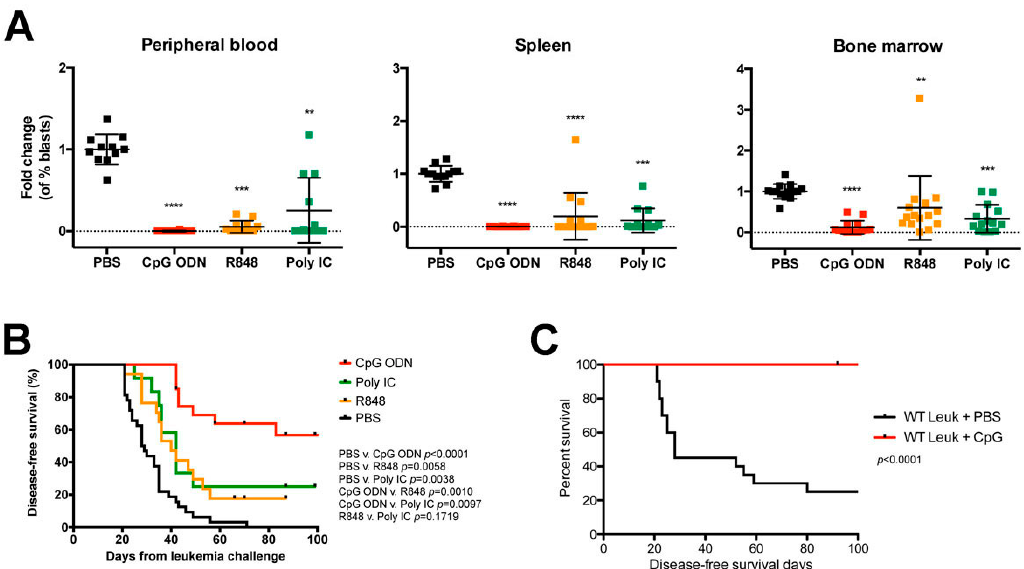
Figure 4. Endosomal TLR-mediated immune stimulation induces protective immune responses in leukemia-bearing mice. BALB/c mice engrafted with syngeneic primary E μ -ret B-ALL cells were treated with indicated TLR agonists and ( A ) evaluated for disease burden in peripheral blood (left), spleen (middle), and bone marrow (right) six days after the last treatment, or ( B ) monitored for survival. Results shown are pooled from five independent experiments. PBS-treated (n = 11), median survival = 28.5 days; CpG ODN-treated (n = 16); R848-treated (n = 16), median survival = 40 days; polyI:C-treated (n = 16), median survival = 42 days. ( C ) CD1d-deficient BALB/c mice engrafted with CD1d+ primary E μ -ret B-ALL cells and treated with PBS (n = 20) or CpG (n = 16). (A) Dunn’s multiple comparisons test, bars represent mean ± S.D. ** p < 0.01, *** p < 0.001, **** p < 0.0001. (B,C) Log-rank test.